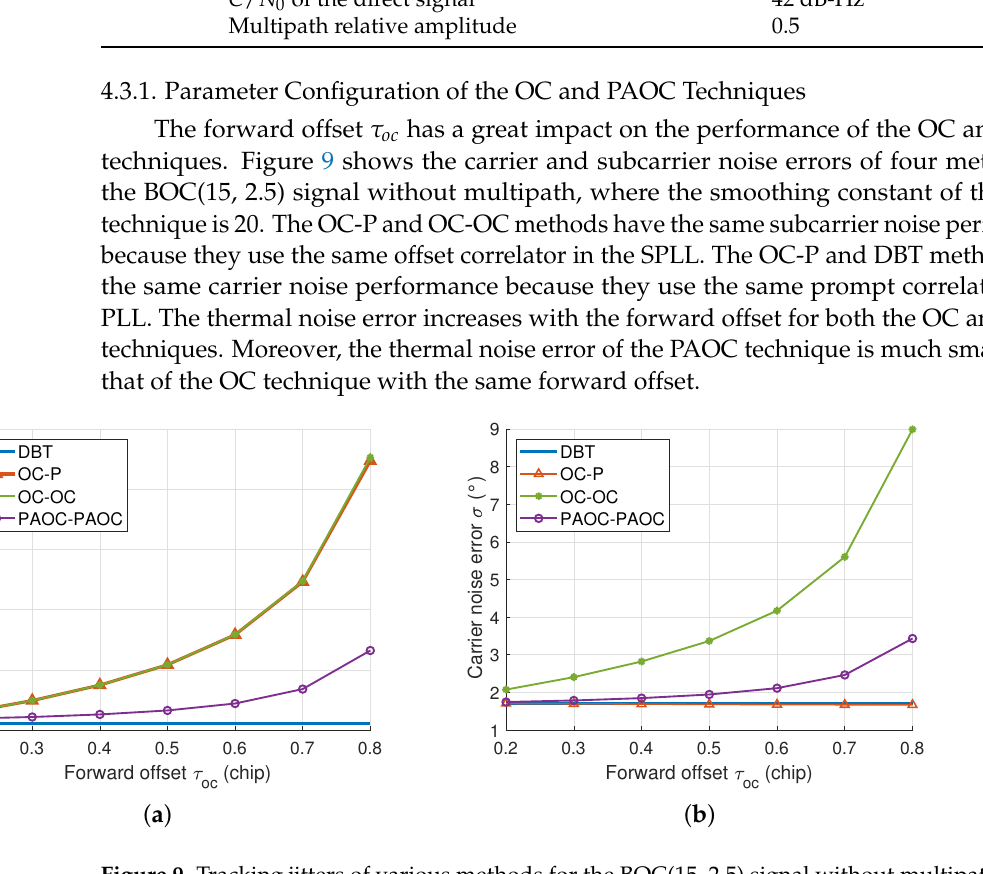
Table 2. Common parameters for all subsequent simulations. Parameter Value Front-end bandwidth